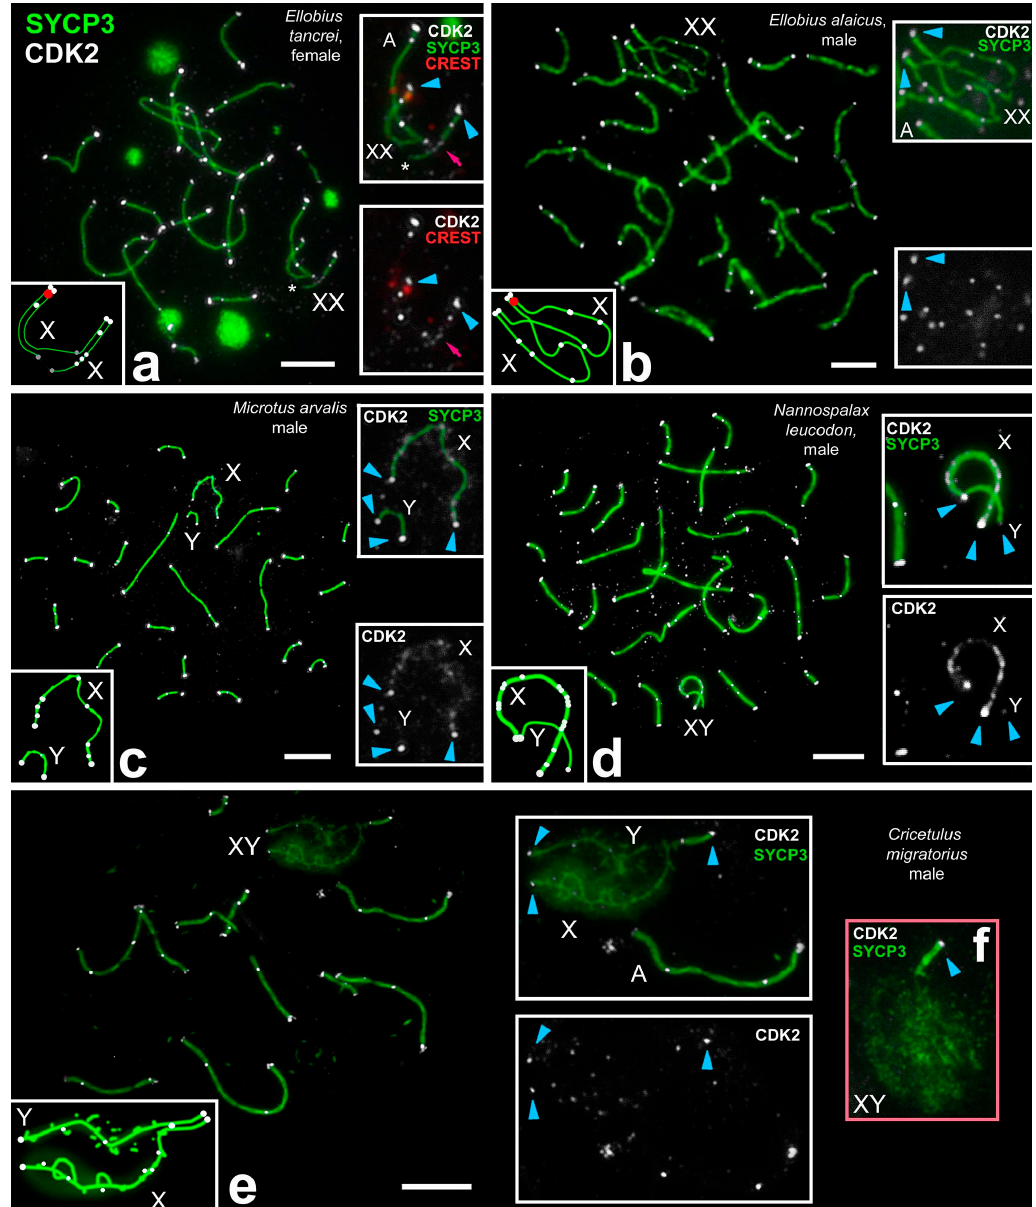
Figure 5. CDK2 localization in meiotic chromosomes of males and females of distinct rodent species. In all species, CDK2 (white) localized in the telomeric and interstitial sites of autosomes (A). Blue arrowheads point to telomeric CDK2 localization in sex bivalents (XY). Schemes of sex chromosome synapsis, centromeric regions, and CDK2 dots are shown in the left bottom insets ( a – e ). ( a ) Pachytene oocyte of the mole vole E. tancrei . An incomplete synapsis occurred in the central part of the sex (XX) bivalent (white star). There were different CDK2 signals: Strong ones in the telomeric and interstitial sites, and weak signals in the synapsed parts of the sex bivalent (pink arrow). ( b ) Pachytene spermatocytes of the mole vole E. alaicus . CDK2 signals were detected in the telomeric and interstitial sites for all bivalents. A weak CDK2-cloud was visualized around the asynaptic area of XX. ( c ) In the pachytene spermatocyte of the vole M. arvalis X and Y were asynaptic (without synapsis between them). The X chromosome showed numerous CDK2 foci (not intense here). The Y chromosome showed CDK2 foci in telomeric sites only. ( d ) In the pachytene spermatocyte of the mole rat N. leucodon numerous CDK signals appeared in the asynaptic part of the X chromosome. Y had telomeric CDK2 foci only. ( e ) Pachytene spermatocytes of the hamster C. migratorius. Autosomes had the same regularities: Telomeric and one or two interstitial sites were CDK2-positive. Rare CDK2-dots were identified in asynaptic regions of XY. ( f ) In the late pachytene hamster spermatocyte, asynaptic X- and Y-axes had diffused SYCP3. Scale bar ( a – e ) = 5 µ